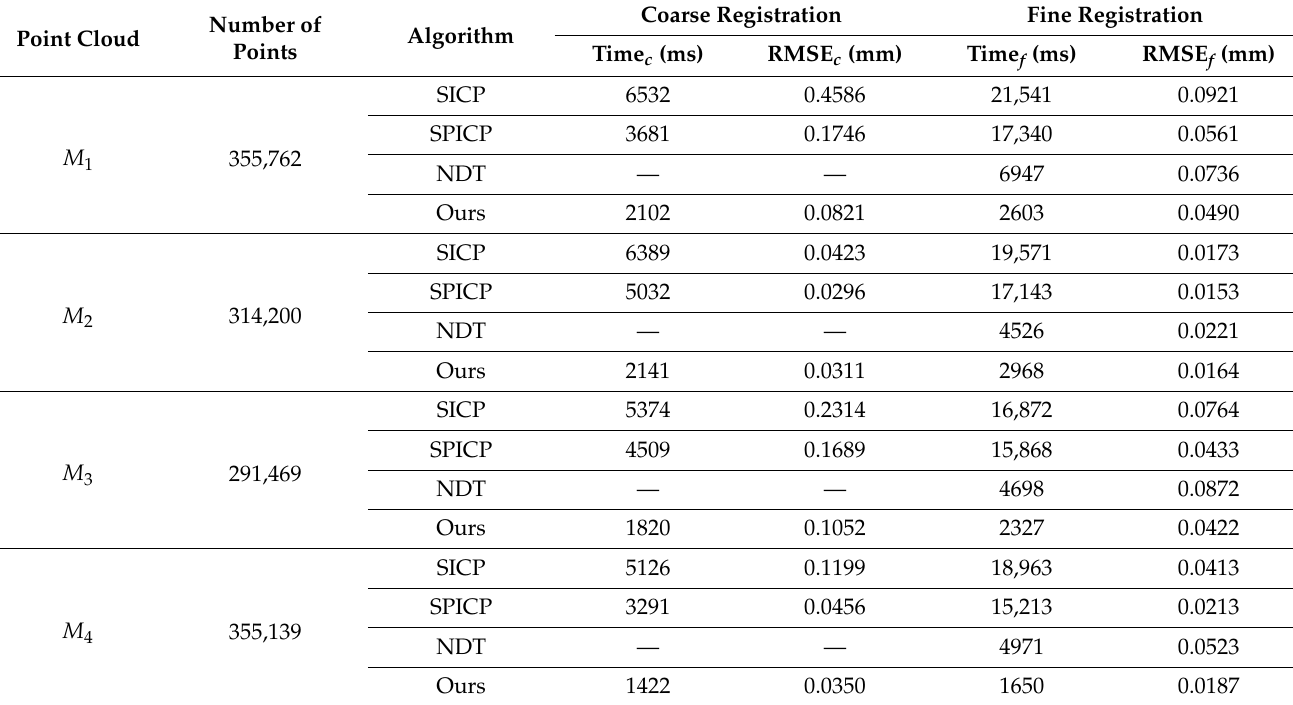
Table 3. Performance comparison of different algorithms in coarse and fine registration